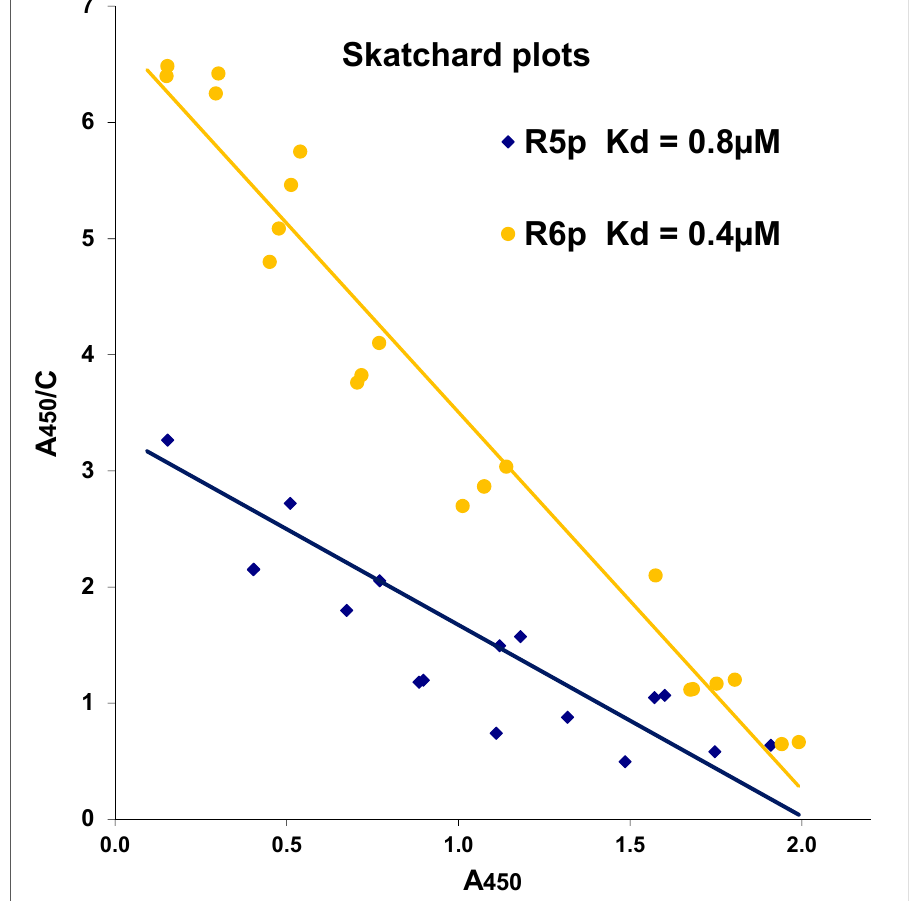
Figure 5. Affinity of peroxidase-labeled fetuin for virions of R5p and R6p strains. The results of testing Fet-HRP on a plate coated with R5p and R6p viruses are presented in Scatchard coordinates. The X -axis is the A 450 signal reflecting the amount of bound fetuin, and the Y -axis is the ratio of the A 450 signal to the fetuin concentration (expressed in μ M of sialic acid) in the solution. Result of a typical experiment is presented.